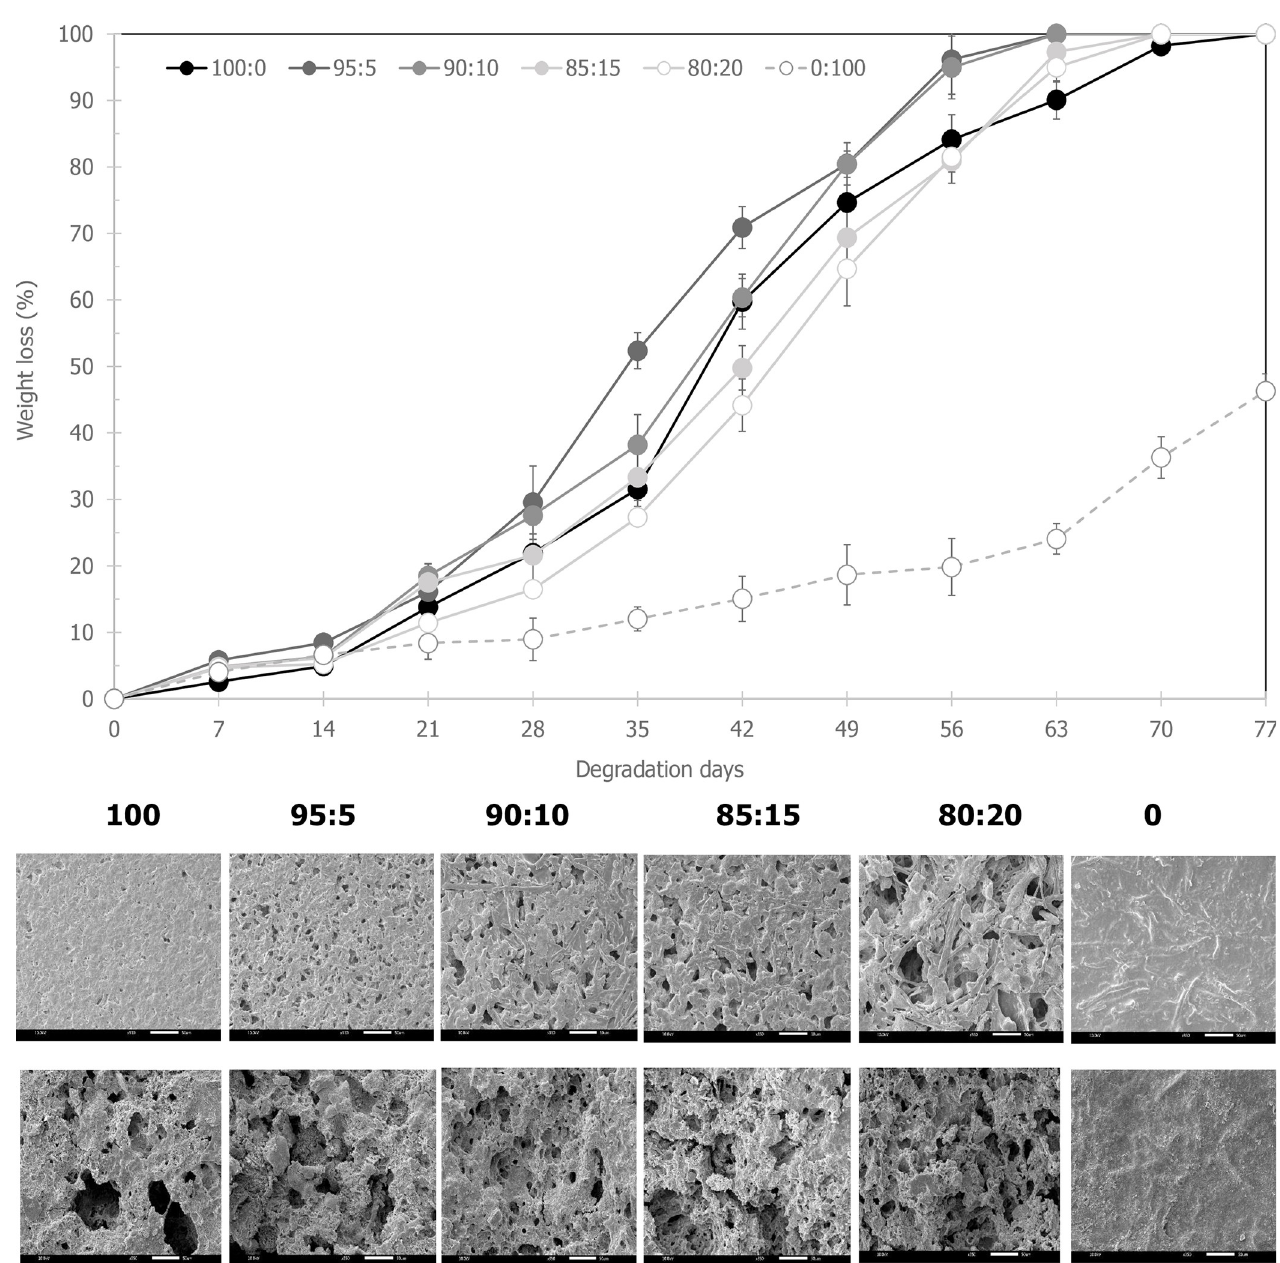
Fig 11. Degradation time courses in laboratory-scale fertilized soil conditions in soil burial test for 77 days (A) % weight loss PHB/esterified PALF-MCC laurate biocomposite films and (B) SEM micrographs of surface morphology of PHB/esterified PALF-MCC laurate biocomposite films before and after 63 days.